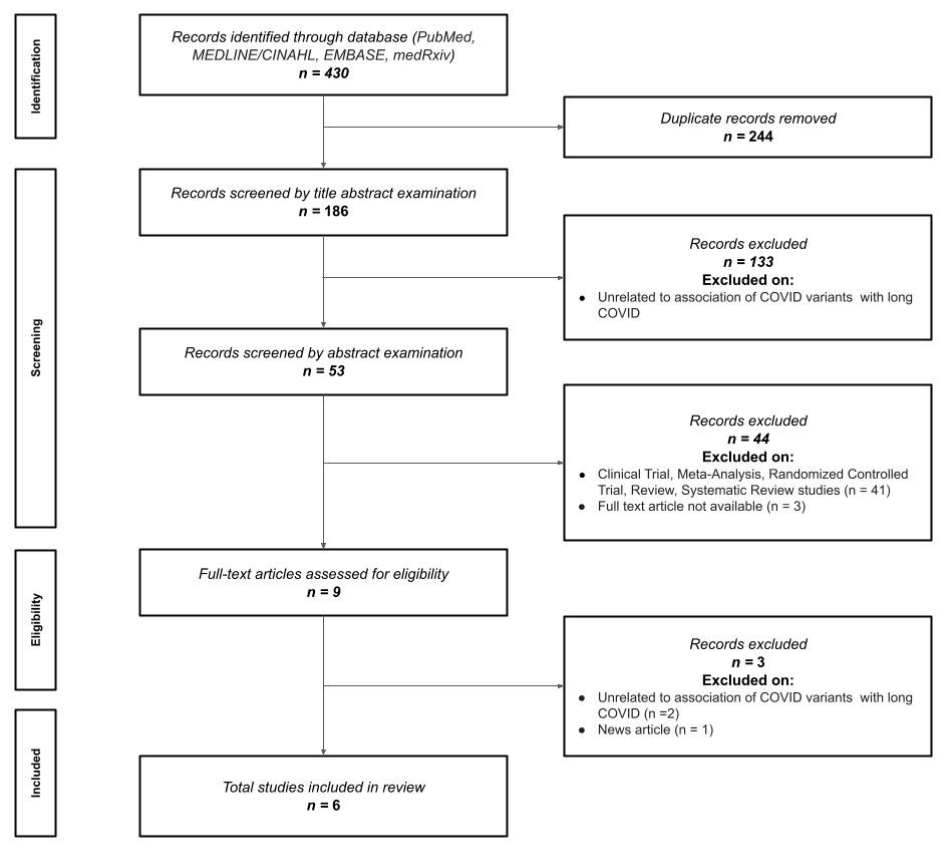
Figure 1. Preferred Reporting Items for Systematic Reviews and Meta-Analyses (PRISMA) flow diagram. n : number of studies